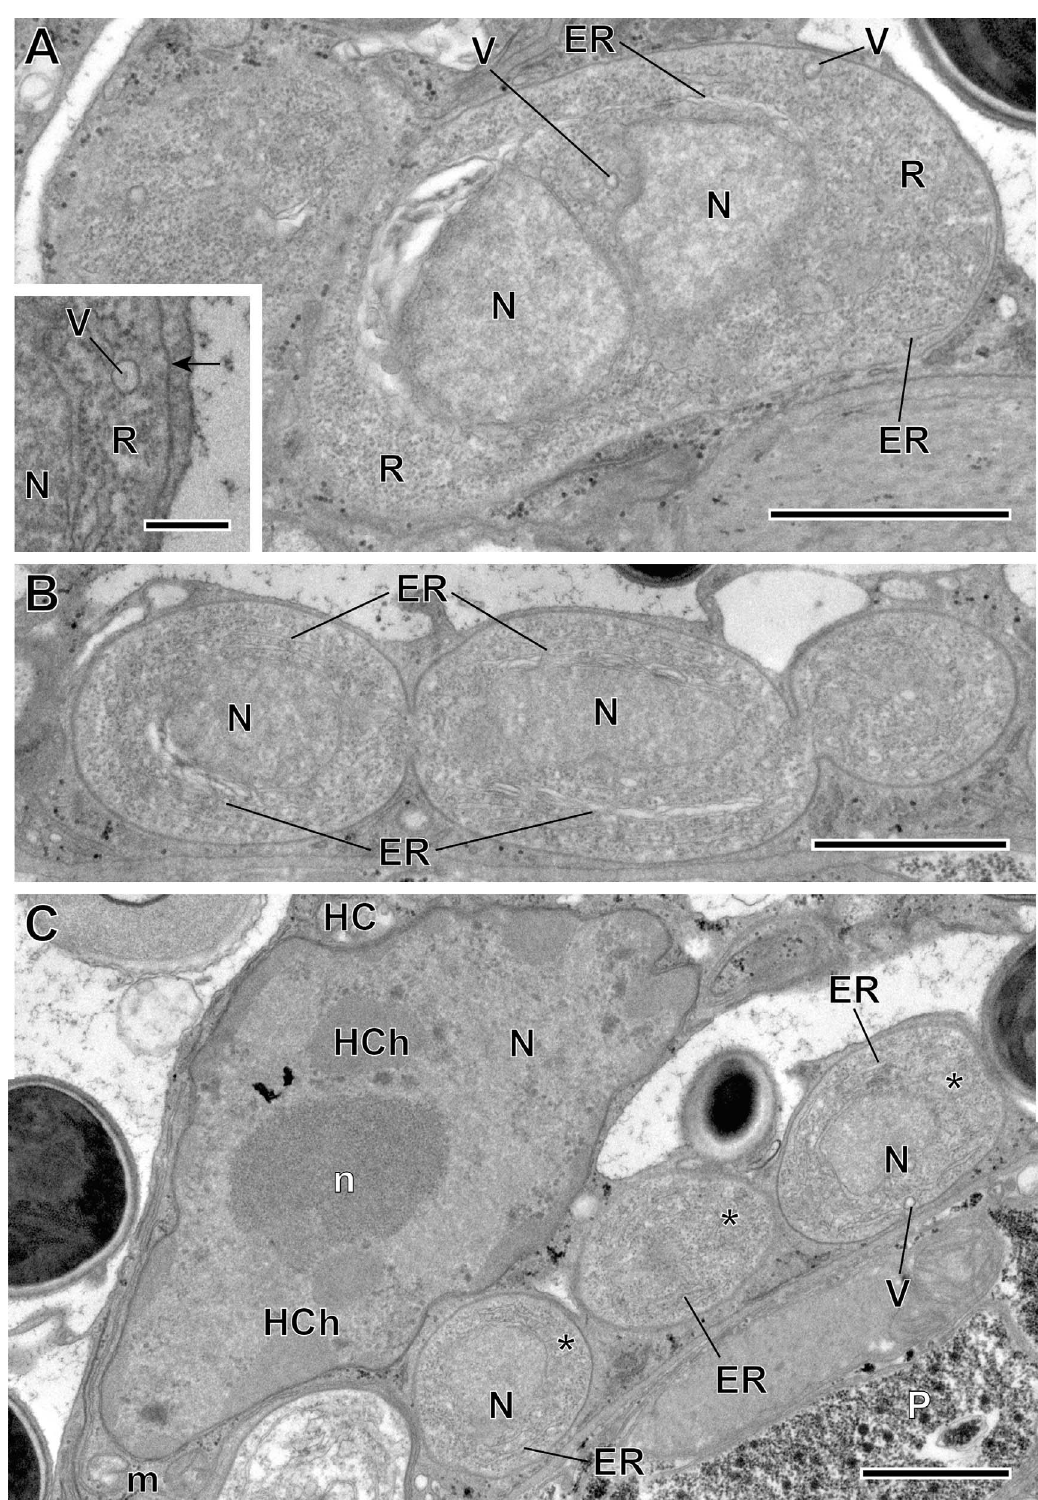
Figure 4. Merogonic stages of Toguebayea baccigeri n. gen., n. sp. (A – B) Dividing meronts; (C) Merozoites (*) in a host cell (HC); (inset) Detail at high magni fi cation of the meront plasma membrane (black arrow). ER, endoplasmic reticulum; HCh, heterochromatin cluster; m, mitochondrion; N, nucleus; n, nucleolus; P, parenchyma; R, ribosomes; V, vacuoles. Scale bars: A – C = 1 l m; inset = 0.2 l